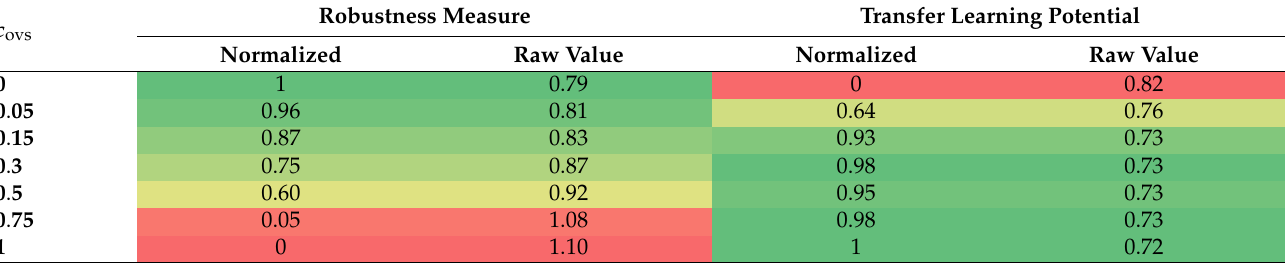
Table 4. Oversampling convergence